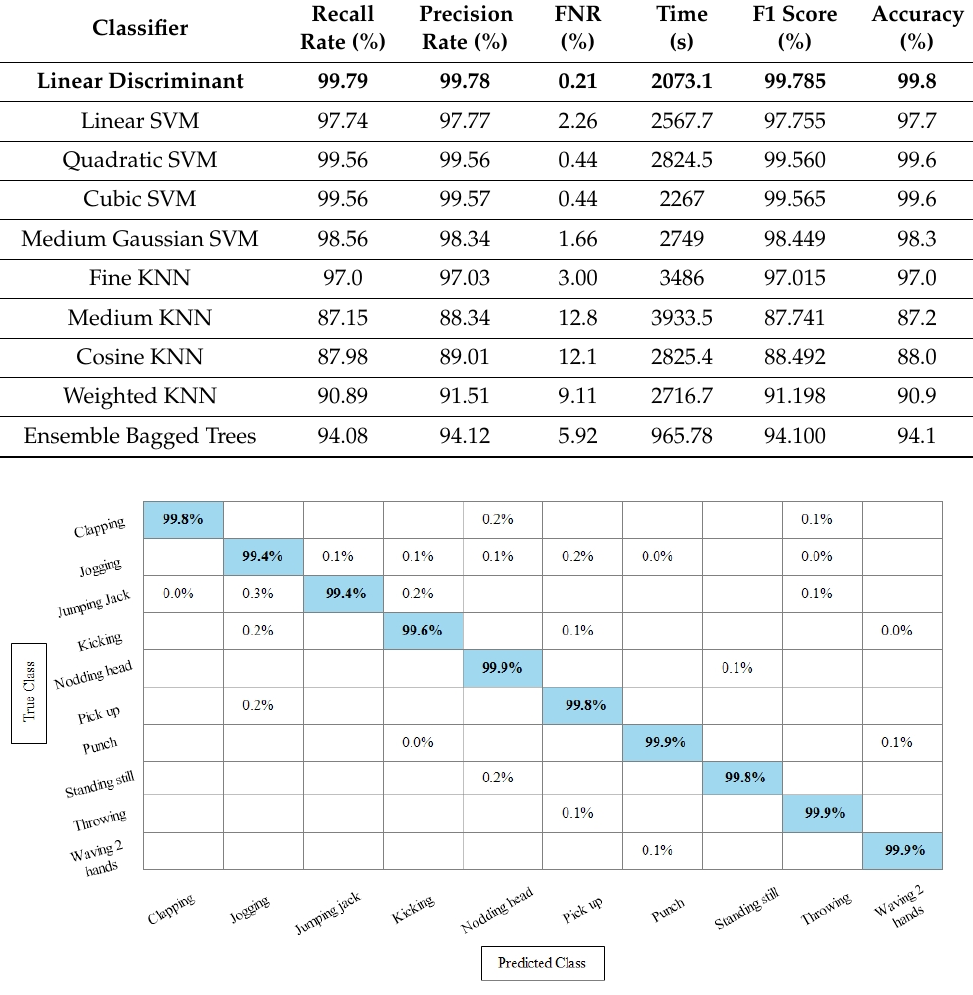
Figure 10. TPR-based confusion matrix of Linear Discriminant classifier after fusion of deep features using SbE approach.